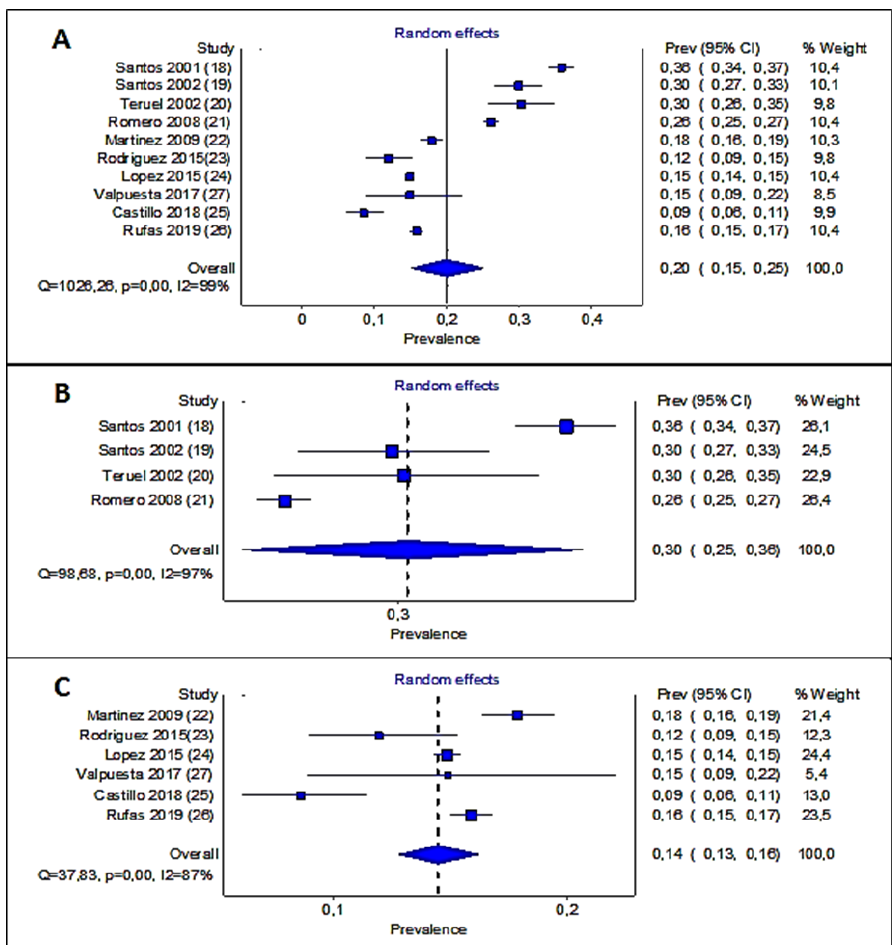
Figure 2. Forest plot graph of the meta-analysis has been constructed taking into account that the average prevalence is 19.93%. ( A ) data of all studies, ( B ) studies conducted between 2001 to 2008, ( C ) studies conducted between 2009 to